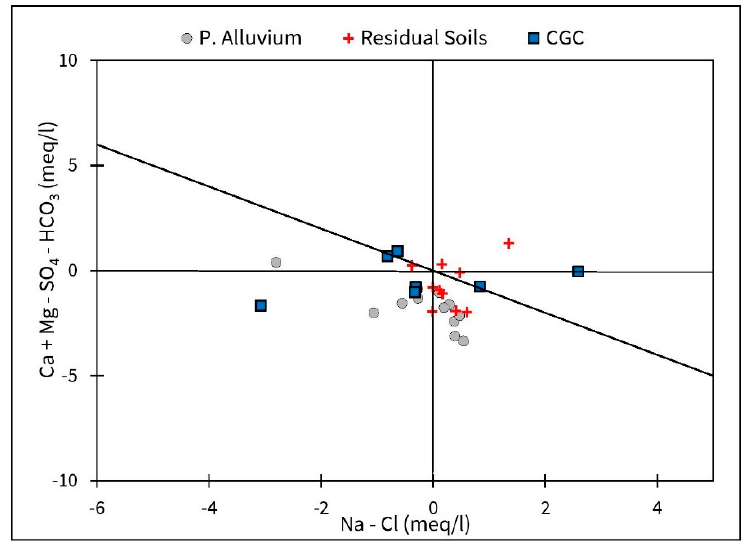
Figure 9. Ca + Mg − SO 4 − HCO 3 vs. Na − Cl plot.